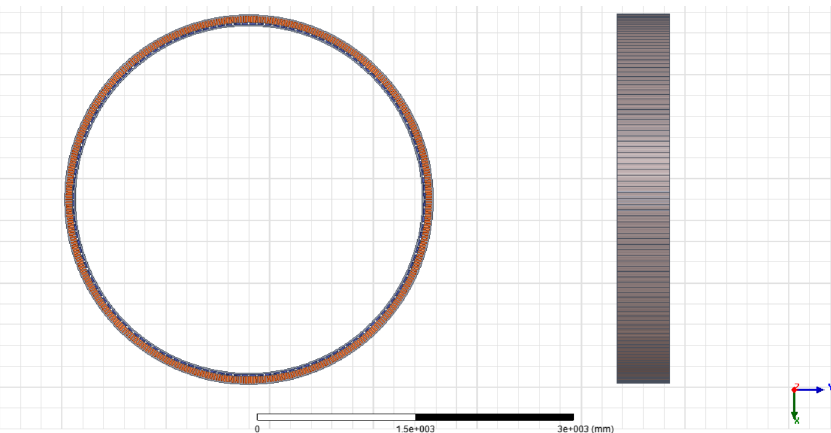
Figure 20. Front and lateral view of the designed (3:1) geared generator at the power rating of 1.5